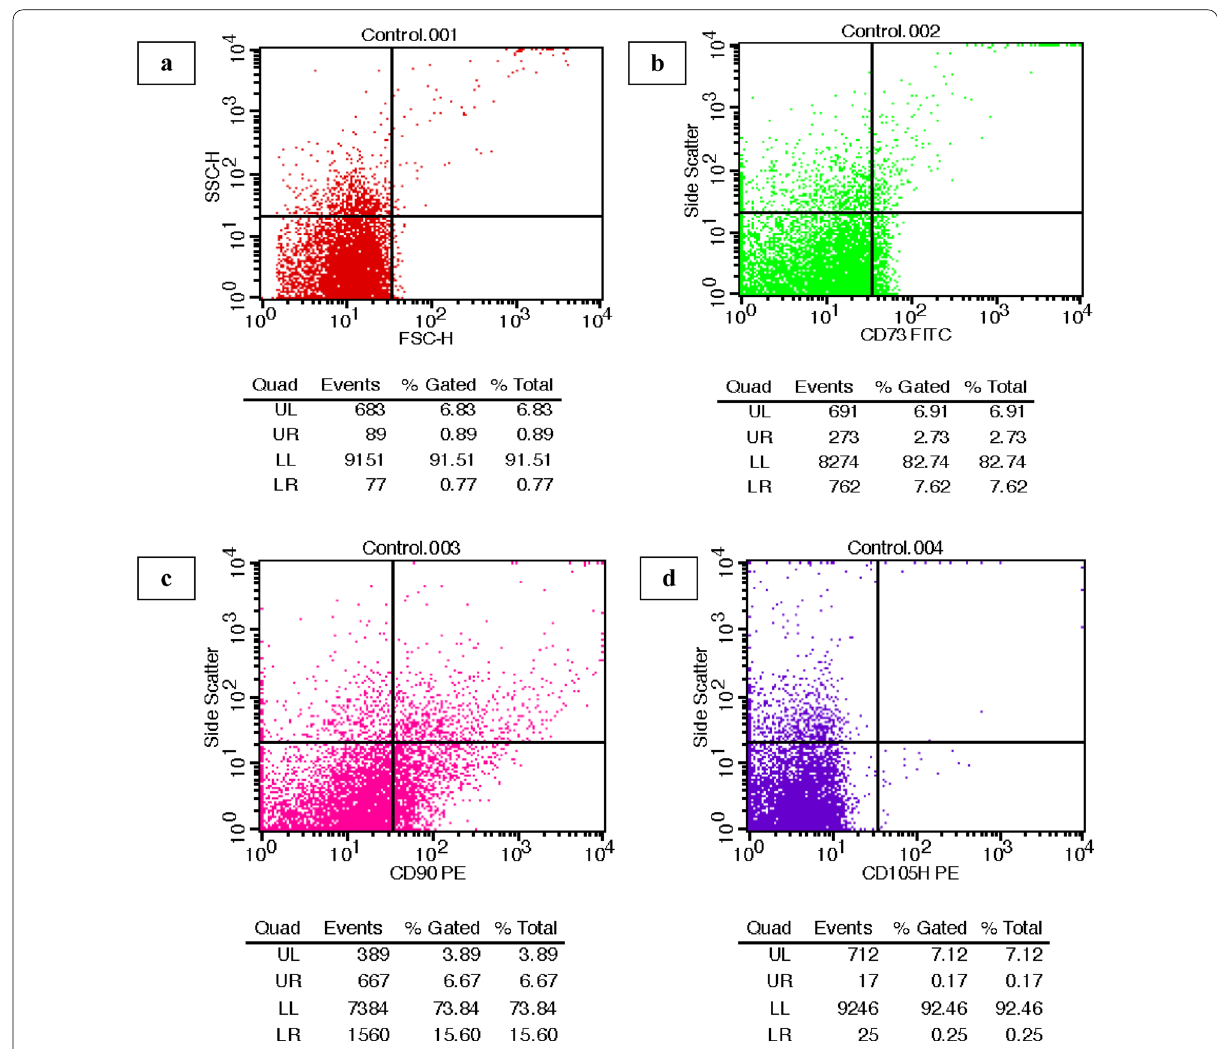
Fig. 7 Dot blot results for the stem cell-specific markers: a control; b CD 73 FITC; c CD 90 PE; d CD 105